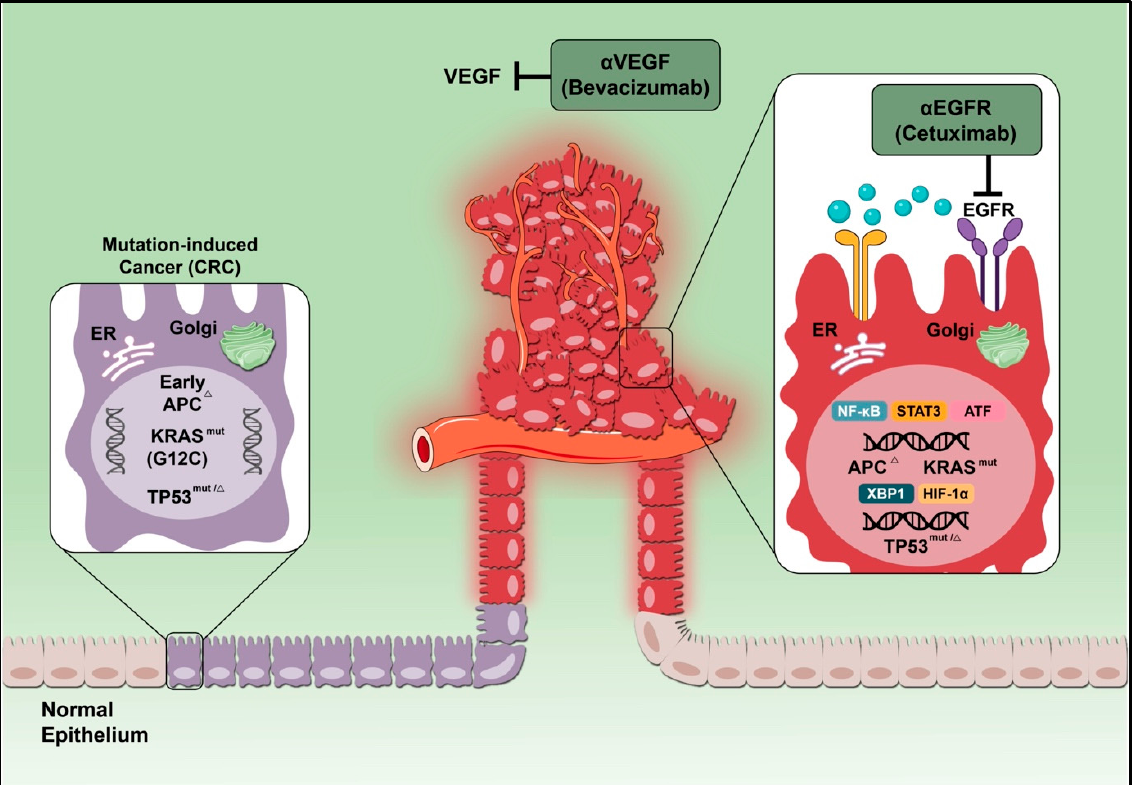
Figure 3. Schematic illustration showing factors that contribute to the development of CRC pathogenesis. Mutation-induced CRC could be a result of new mutations or pre-existing mutations, specifically mutations in tumor suppressor genes and oncogenes. CRC: mutation-induced cancer, VEGF: vascular endothelial growth factor, EGFR: epidermal growth factor